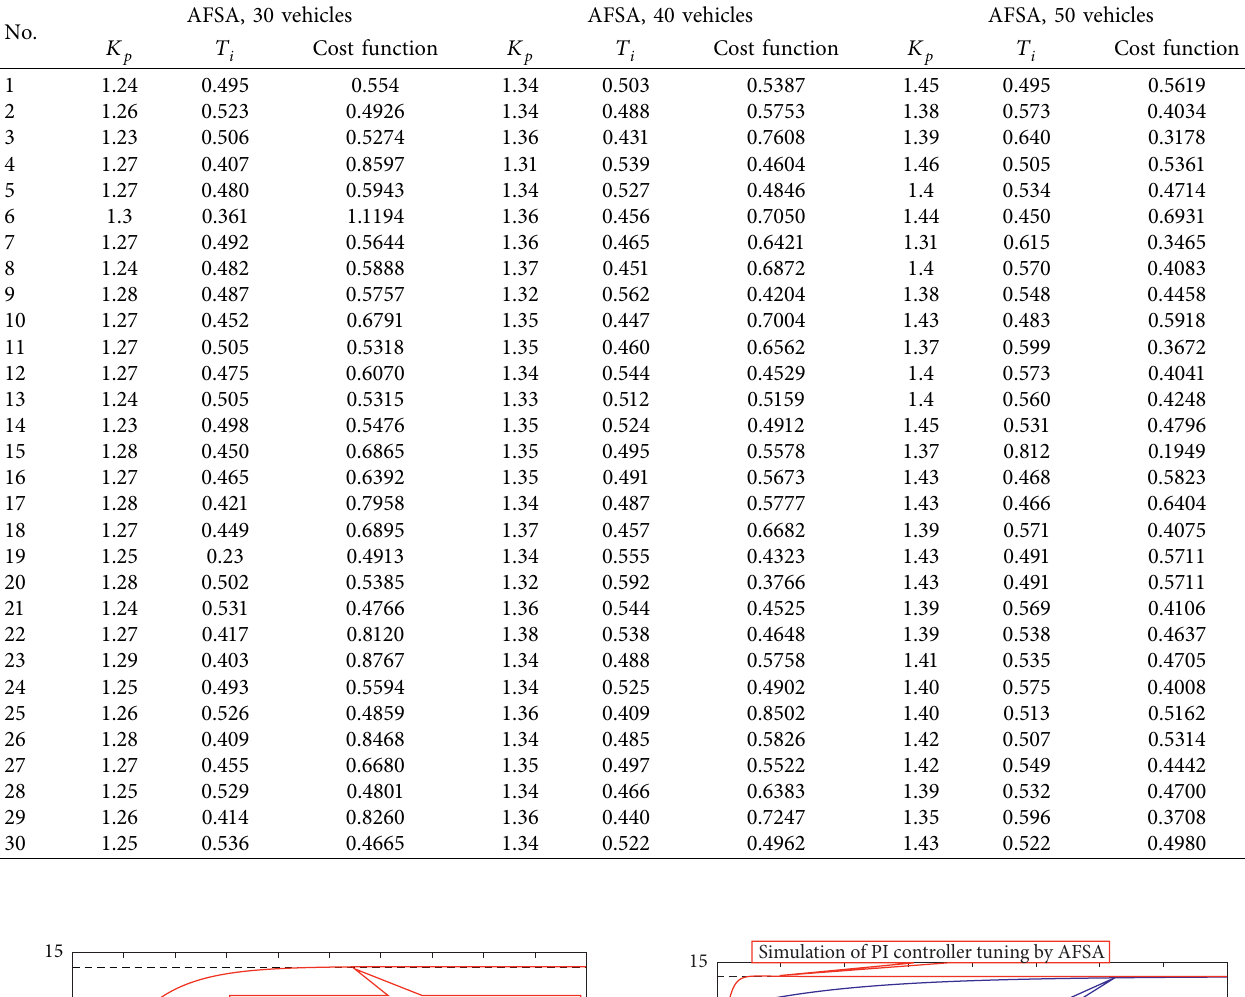
Table 3: Parameter setting of AFSA.